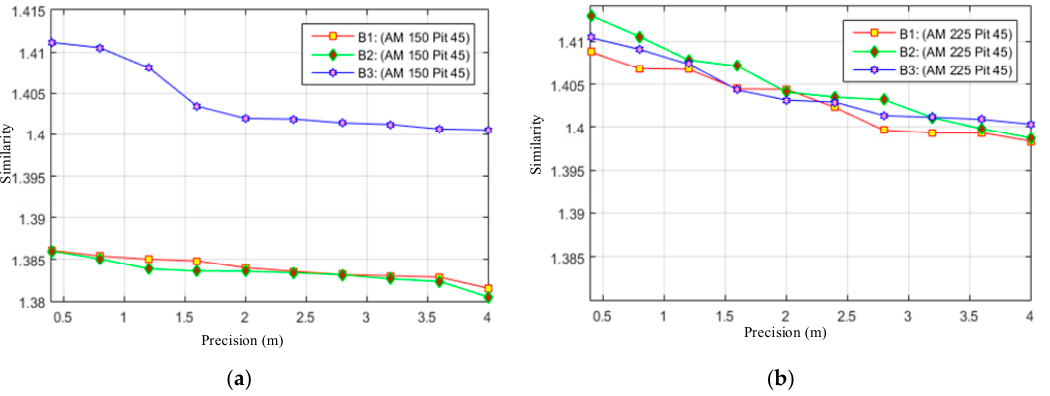
Figure 4. “Precision” versus “ S Φ ”. “Precision” is obtained by Equation (9) with all sampled points of